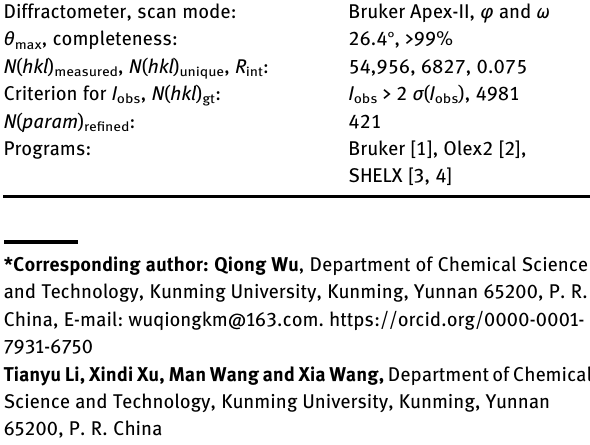
Table 1 contains crystallographic data and Table 2 contains the list of the atoms including atomic coordinates and